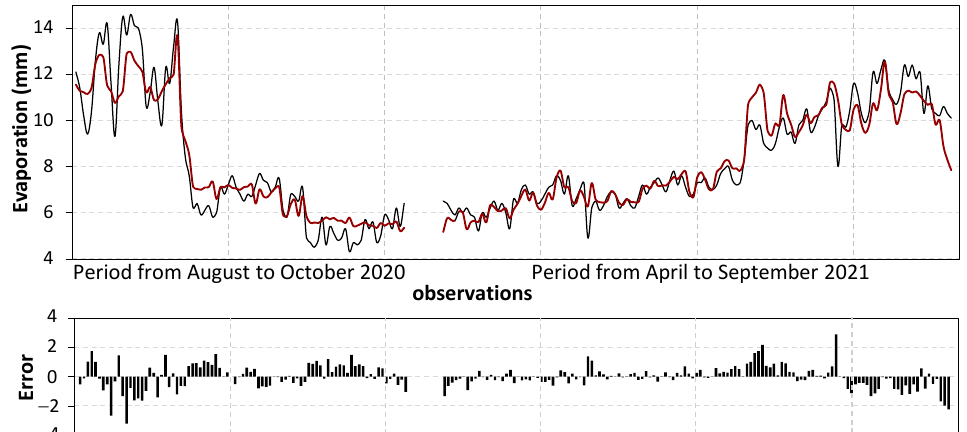
Figure 3. Behaviour of (Model A) DT in predicting the output variable Evaporation. The red line shows the behaviour of (Model A) DT and the black line shows the actual values in the analysed time periods. The residual error plot shows for each observation the error between the predicted and the real